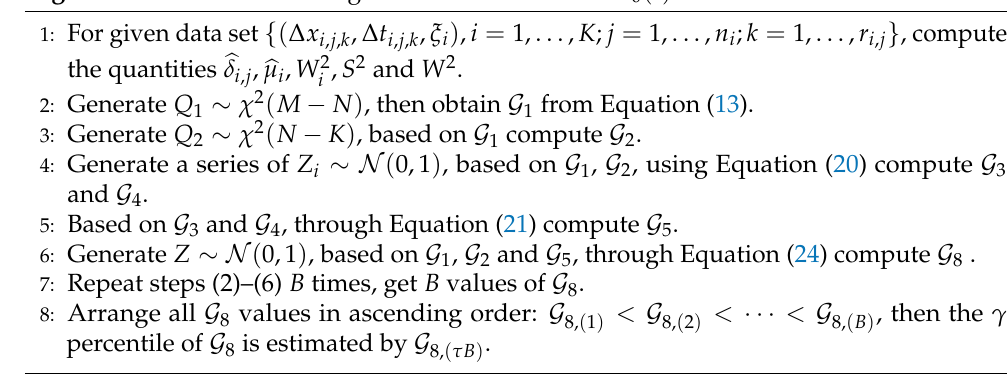
Algorithm 3 Percentile for degradation characteristic X 0 ( t ) .